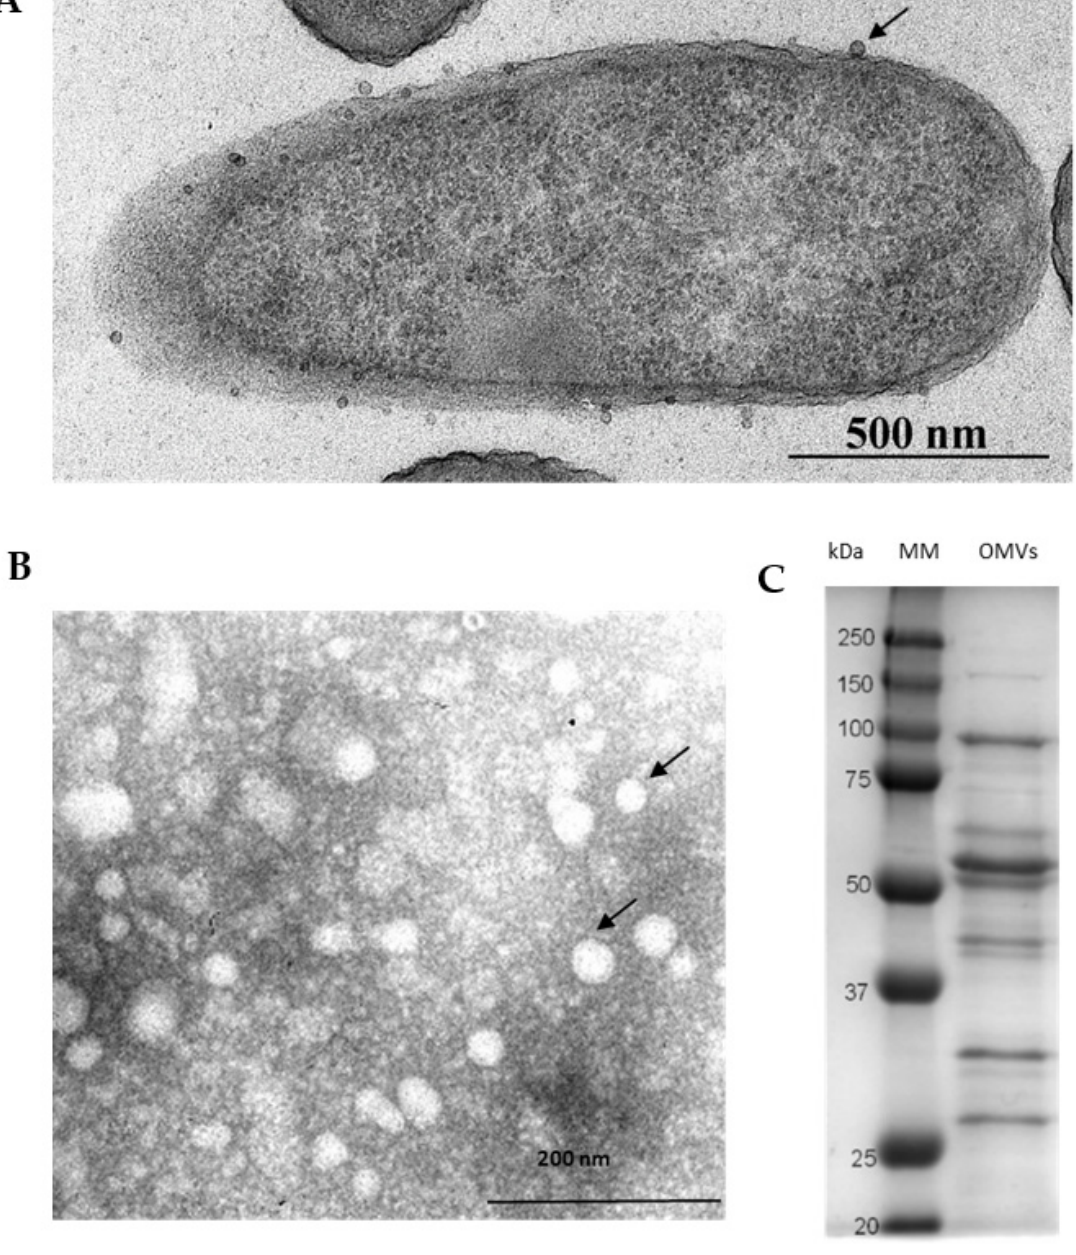
Figure 1. Physical characterization of outer membrane vesicles (OMVs) produced by P. aeruginosa PAO1 cells: ( A ) TEM micrograph of P. aeruginosa cells releasing OMVs (magnification, × 12,000); ( B ) TEM micrograph of isolated P. aeruginosa OMVs, with vesicles indicated by arrows (magnification, ×30,000); ( C ) the representative proteinogram of 12% SDS-PAGE electrophoresis of OMVs; the protein profiles were visualized using Coomassie staining.